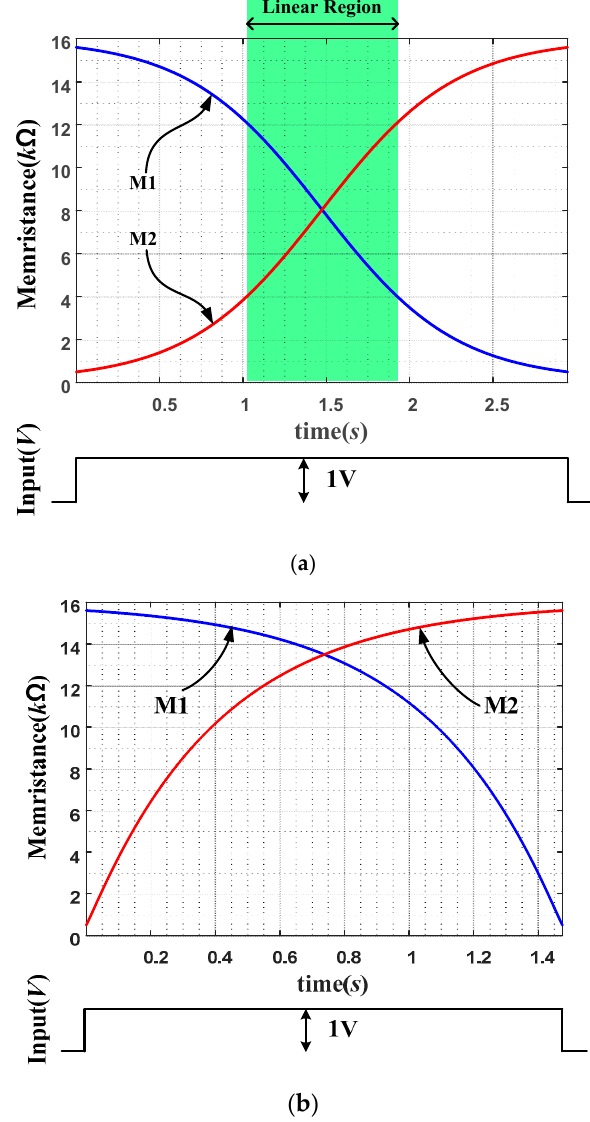
Figure 12. Linearized variation of memristance at the middle of the graph when a constant voltage source is applied at an anti-serial connection of two nonlinear memristors ( a ) and nonlinear variation of memristance of individual memristors for comparison when the programming signal is applied at each memristor individually ( b ).